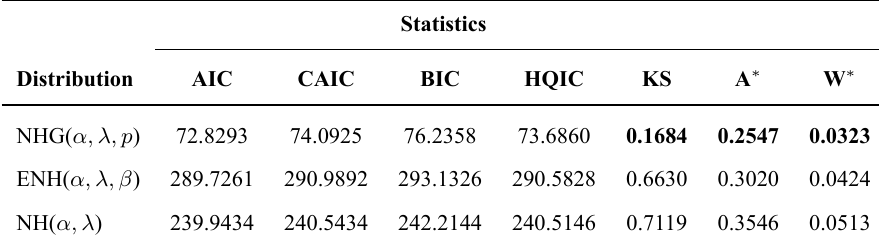
Goodness-of-fit